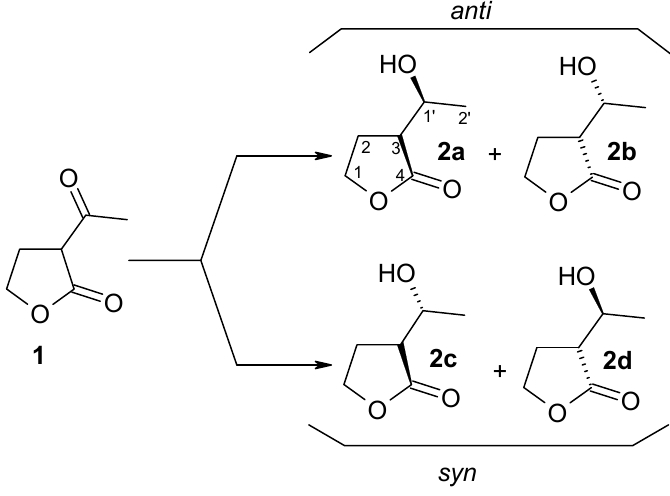
Figure 1. Structures of substrate 1 and stereoisomers of product 2 ( anti 2a (+)-(3 S ,1’ S ), 2b (-)-(3 R ,1’ R ) and syn 2c (-)-(3 S ,1’ R ), 2d (+)-(3 R ,1’ S ).